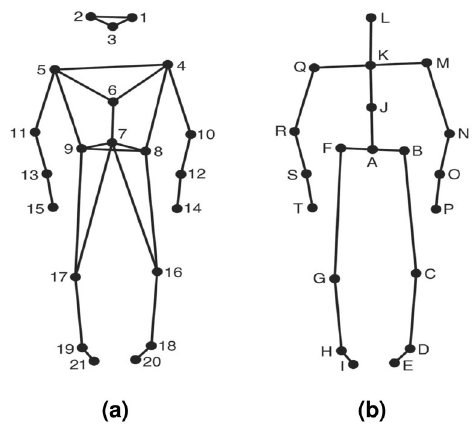
Figure 7. Dataset-1: Marker and joint locations ( a ) Anterior view of the marker locations a stick figure illustration; ( b ) Anterior view of the locations of the secondary markers/joints used in animation and analysis of the data.